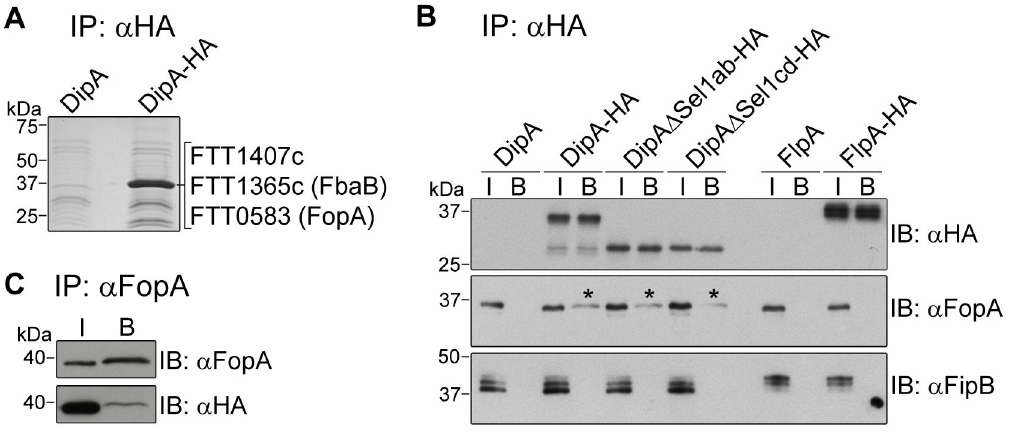
Figure 5. Identification of DipA interacting partners. (A) Code blue stained gel of proteins immunoprecipitated with anti-HA conjugated beads from lysates of SchuS4Δ dipA expressing DipA [SchuS4Δ dipA (p dipA )] or DipA-HA [SchuS4Δ dipA (p dipA-HA )]. Samples were resolved by SDS-PAGE and stained with GelCode® Blue. Protein bands migrating at ~40 kDa were subjected to mass spectrometry-based identification. FTT1407c, FTT1365c and FTT0583 were specifically co-immunoprecipitated with DipA-HA. (B and C) Verification of FopA interaction with DipA by immunoblot analysis. (B) Lysates from SchuS4Δ dipA expressing DipA derivatives (DipA, Dip-HA, DipAΔSel1ab-HA, DipAΔSel1cd-HA), or SchuS4Δ flpA expressing FlpA derivatives (FlpA, FlpA-HA) were subjected to immunoprecipitation (IP) using anti-HA conjugated beads followed by immunoblot (IB) analysis with anti-HA, anti-FopA and anti-FipB antibodies. I denotes sample input; B denotes bound fraction. (C) Lysate from SchuS4Δ dipA expressing DipA-HA was subjected to immunoprecipitation (IP) using anti-FopA antibodies followed by immunoblot (IB) analysis with anti-FopA antibodies to detect FopA and anti-HA antibodies to detect Dip-HA. I denotes sample input; B denotes bound fraction. doi: